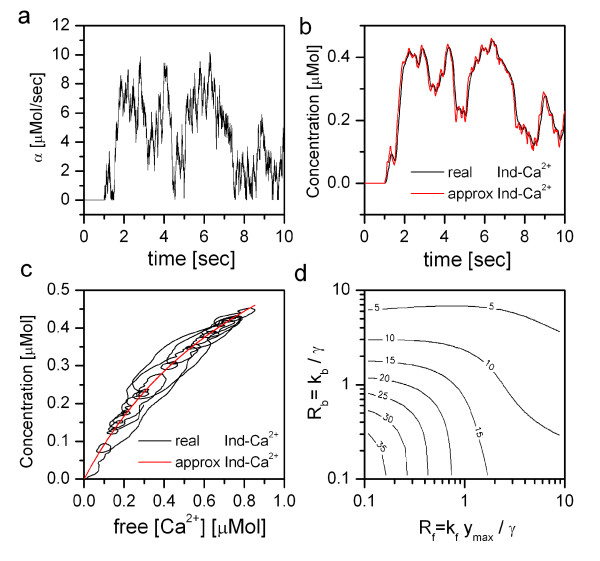
Results of numerical integration of eqs. (1) and (2). a: Calcium influx α(t). b: Real and approximated indicator-bound calcium concentrations, given the following parameters: pump rate γ(t) = 10 Hz, initial free indicator concentration ymax = 1 μMol, indicator backward rate kb = 10 Hz and indicator forward rate kf = 10 Hz/μMol. This corresponds to Rb and Rf = 1.0. c: Real and approximated indicator-bound calcium as a function of the free cytosolic calcium. d: Root-mean-square (rms) of the difference between real and approximated signal as a function of the two dimensionless kinetic parameters Rb and Rf. Number on the iso-rms contour lines indicate the rms value as a percent of the real indicator-bound signal.